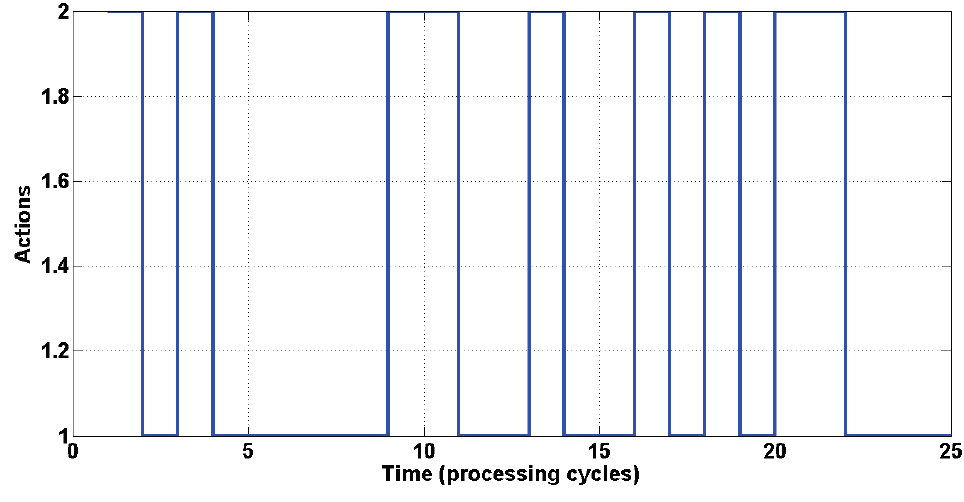
Figure 4. The switching sequence among the two techniques.